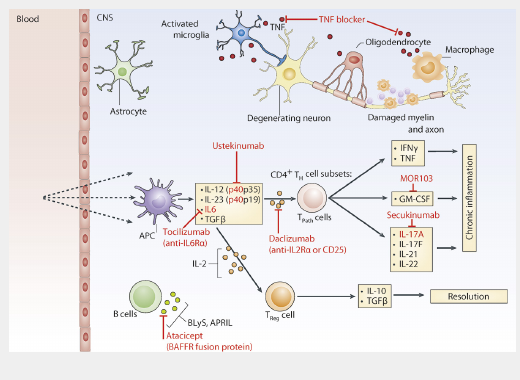
Key cytokines in the pathogenesis of multiple sclerosis. In patients with MS and in its experimental models EAE, various immune cells have been shown to produce and react to pro- and anti-inflammatory cytokines in the inflamed CNS. The main cytokines secreted by antigen-presenting cells, pathogenic CD4+ Th cell subsets and T regs are shown. Potential cytokine targets for therapy and drugs are indicated in red. TNFα is expressed by T cells but also by microglia and macrophages. Its blocking has failed in clinical MS trials possibly because it has also homeostatic effects in the CNS and is important for remyelination. Other cytokine inhibitors like ustekinumab, which targets the p40 subunit of IL-12 and IL-23, involved in the generation of pathogenic CD4+ Th cell subsets has recently been tested in clinical trials and was unexpectedly ineffective to reduce clinical relapses in MS patients. Studies with neutralizing anti-GM-CSF (MOR103), anti-IL17 (secukinumab) or anti-IL2Rα antibodies (daclizumab) are ongoing and show promising first result in the treatment of MS patients. Blocking of maturation factors of B cells (BLys, APRIL, or in the case of neuromyelitis optica IL-6Rα by tocilizumab) might be another therapeutic approach worth following up. APC = antigen-presenting cell; BAFF = B cell activation factor; CNS = central nervous system; EAE = experimental autoimmune encephalomyelitis; GM-CSF = granulocyte macrophage colony stimulating factor; IFN = interferon; IL = interleukin; MS = multiple sclerosis; T Path = pathogenic CD4+ Th cell subsets; Th = T helper cell; TNF-α = tumour necrosis factor.α; T reg = regulatory T